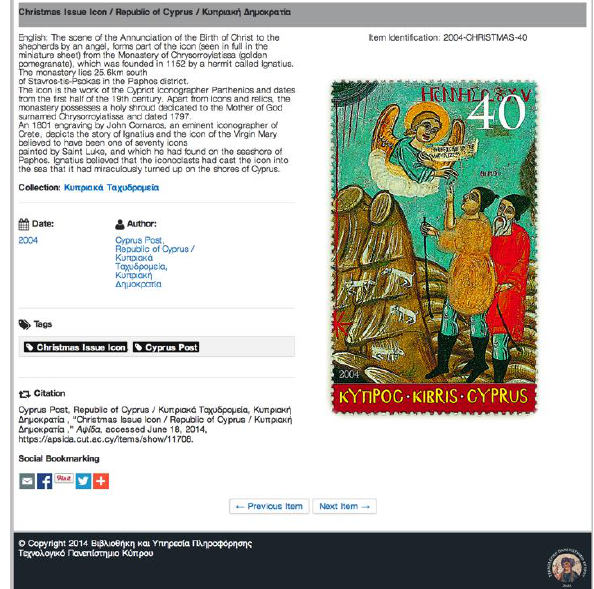
Figure 3. Sample view of a record in the Omeka repository from one of the selected stakeholders: the Postal Services in Cyprus (a stamp representing a fresco in one of the ten painted- churches in